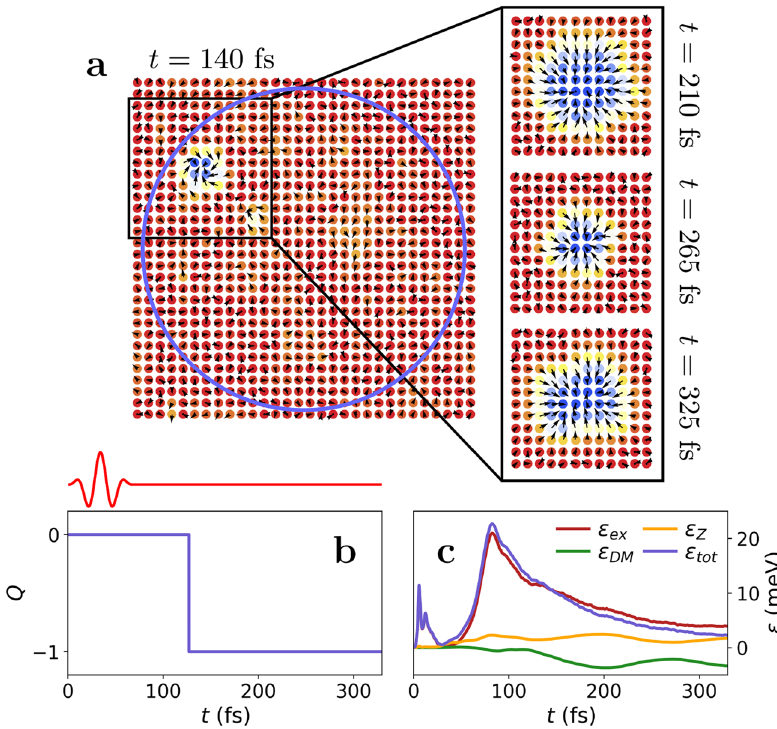
Fig. 1 Laser-induced skyrmion nucleation. a Spin textures of the d -electron system at t = 140 fs (just after skyrmion excitation), 210, 265, and 325fs. The coloring shows the out-of-plane component of the spin vector ranging from S z = − 1 (blue) to S z = 1 (red). The system has 30× 30 sites and the spin parameters are J = 50, D = 25, and B = 10 meV. The s -electrons parameters are t = 1 and α = 0.5 eV, and the s – d exchange coupling is g = 2.5 eV. The laser has a fi eld strength E = 10 9 V/m, frequency (cid:2) h ω = 0.5 eV, pulse length τ = 30fs, and a spot size of ≈ 14nm (indicated by the blue circle). The time-dependent electric fi eld is schematically shown above panel ( b ). b , c Topological charge Q and the energy per spin ϵ = E / N as a function of time. The total energy ϵ tot is decomposed into the exchange, DM and Zeeman contributions ϵ ex , ϵ DM , and ϵ Z